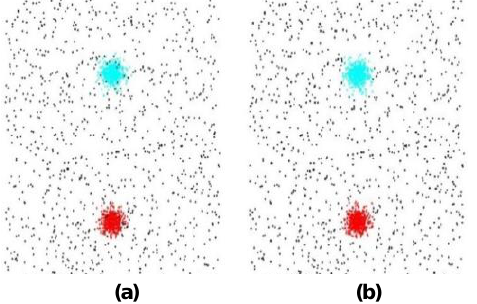
Figure 15. HUALM result on a random Gaussian dataset with 100% of total number of data, injected white noise. a) Two clusters have been shown in red and cyan, and the white noise in black. b) Output of the algorithm shows the ability of the algorithm to eliminate noise and